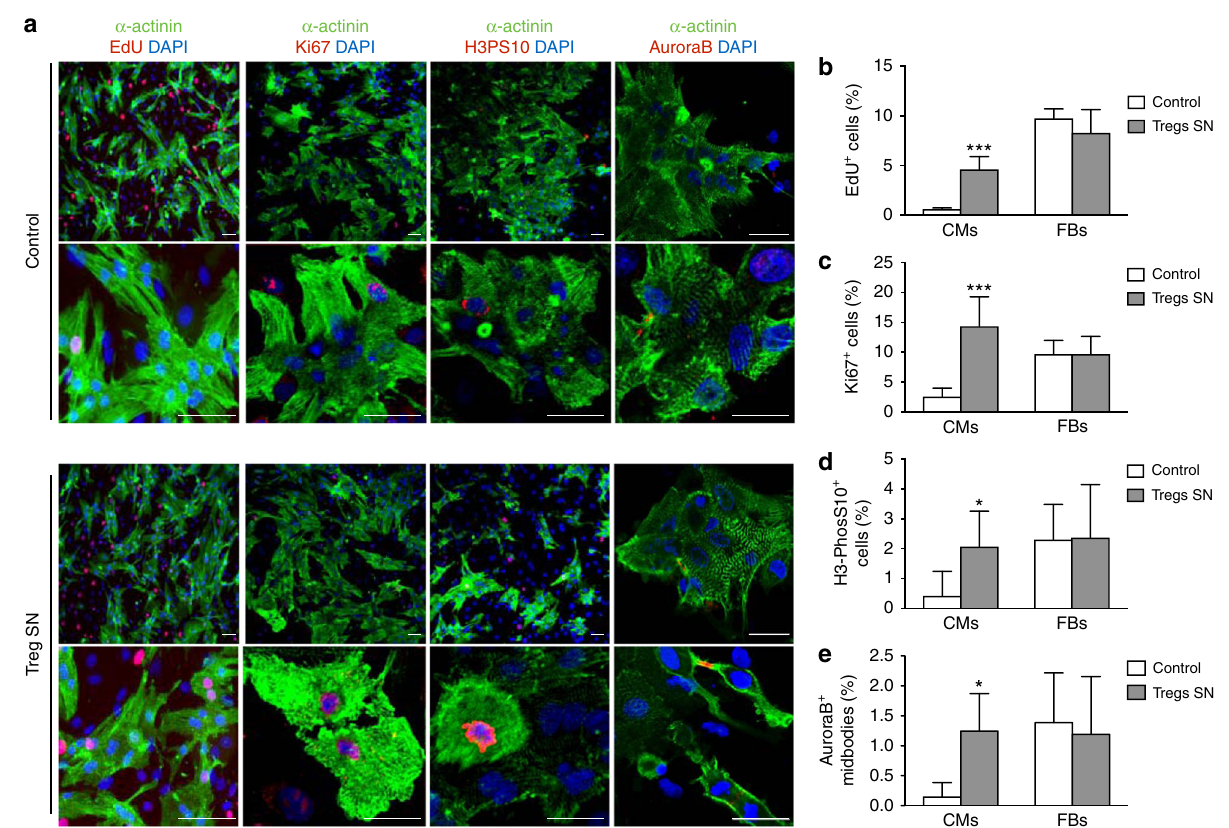
Fig. 2 Tregs promote the proliferation of neonatal CMs. a Rat neonatal CMs were exposed to the supernatant (SN) conditioned by Tregs and stained for various proliferation markers, including EdU incorporation, Ki67, histone H3 phosphorylated on serine10 (H3PS10), and Aurora B. All proliferation markers are stained red, while nuclei are stained blue with DAPI and CMs green using anti- α -actinin antibodies. Control cells were exposed to the medium normally used to culture Tregs, containing recombinant IL2 (50 ng/ml). Scale bar, 25 μ m. b – e . Quanti fi cation of EdU + ( b ), Ki67 + ( c ), H3PS10 + ( d ) cells, and AuroraB + localization in midbodies ( e ) in either CMs (CMs, white bars) or fi broblasts (FBs, gray bars), expressed as the percentage of the total number of nuclei belonging to each cell type. All values are mean ± s.e.m., n = 3 biological replicates. At least 500 cells were analyzed per each replicate using the MetaXpress software. Pairwise comparison was performed with the Student ’ s t -test ( b – e ); * P < 0.05, ** P < 0.01, *** P < 0.001 relative to